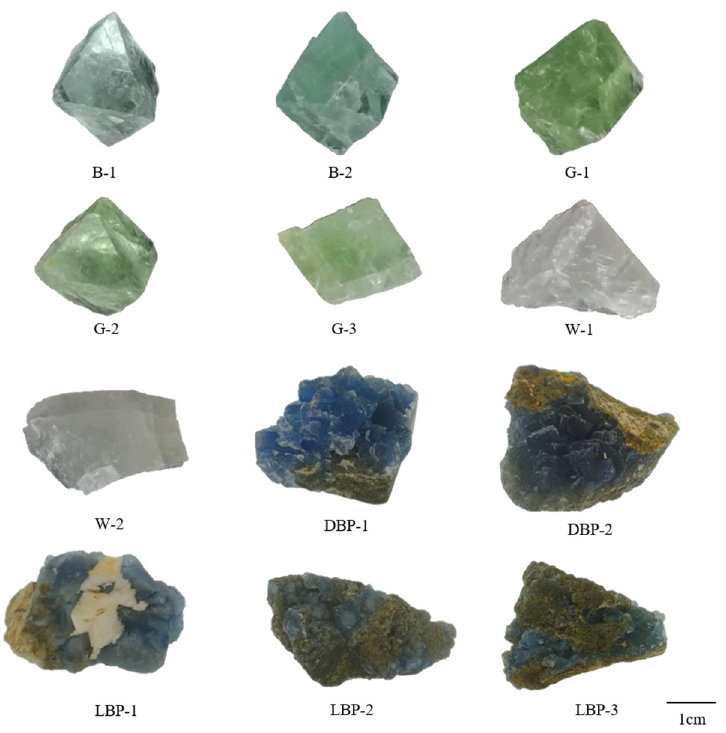
Figure 1. Appearance of fluorite samples for experiment.